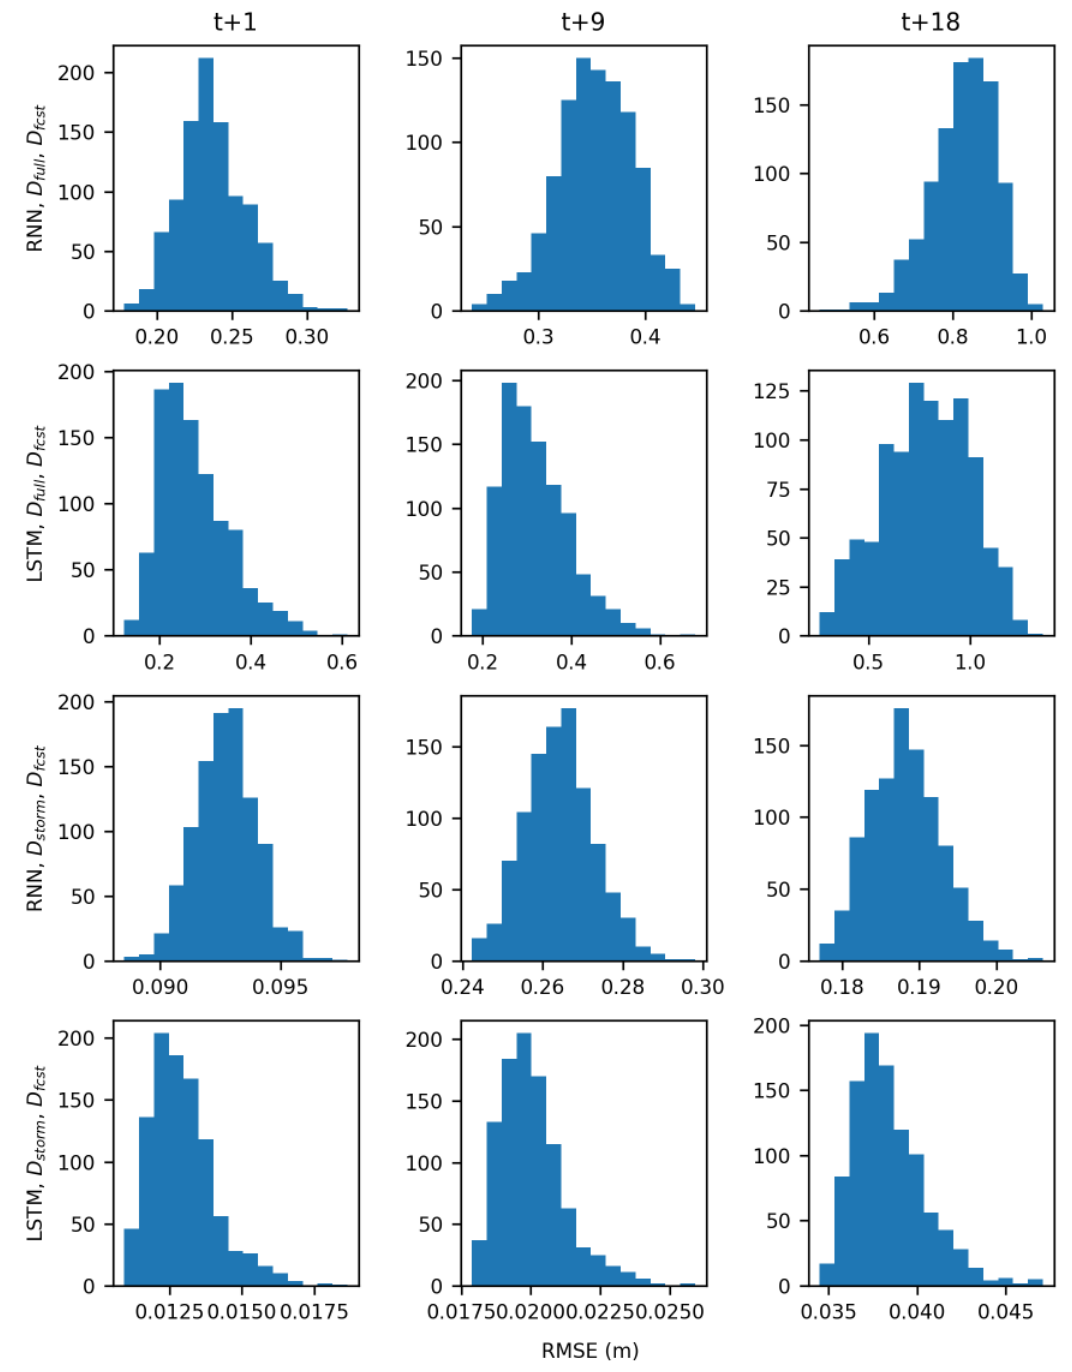
Figure A11. RMSE distributions for GW4 using forecast input data. Columns represent the forecast horizons t + 1, t + 9, and t + 18. Rows are specified as model type, training data, and testing data.